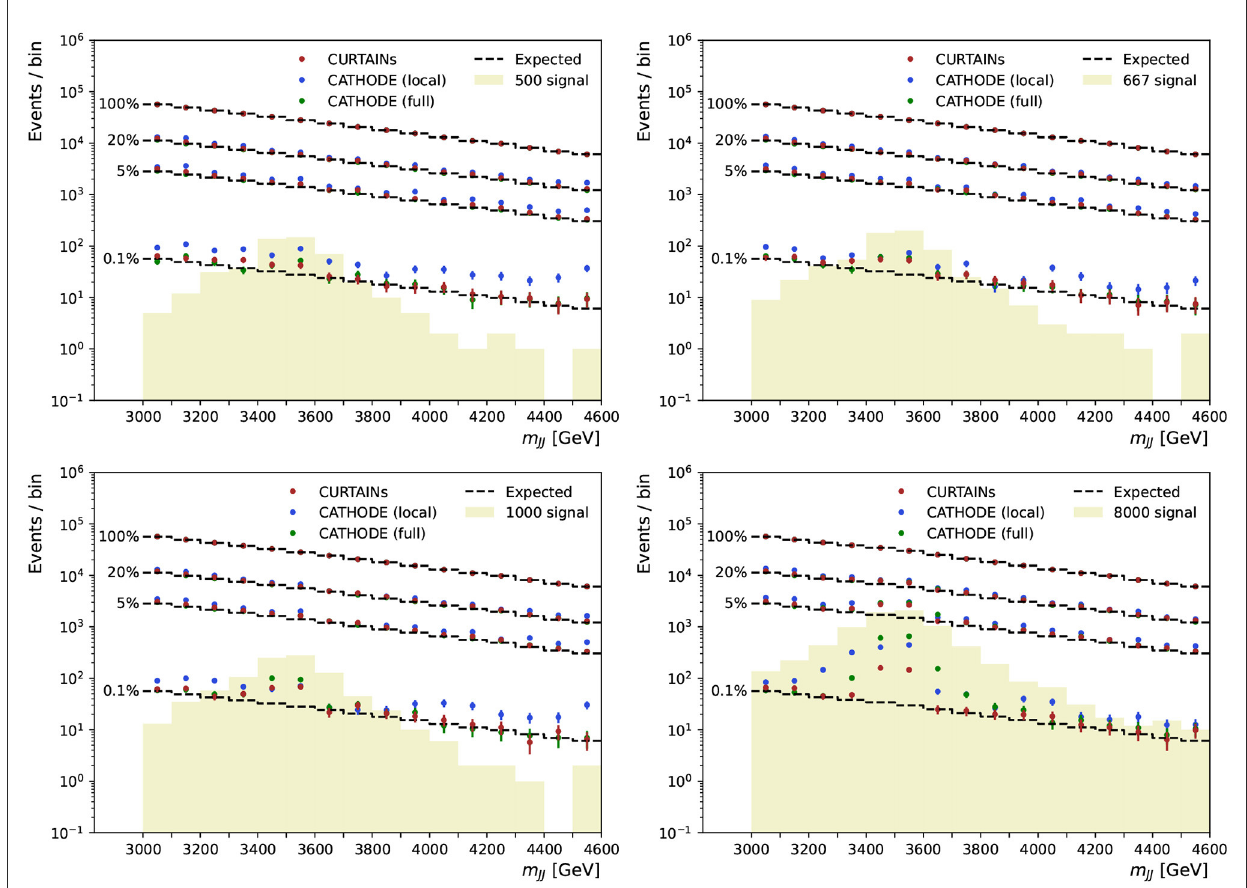
FIGURE10 The dijet invariant mass for the range of signal regions probed in the sliding window, from 3,300 to 4,600 GeV, for the case of samples doped with 500 (top left) , 667 (top right) , 1,000 (bottom left) , and 8,000 (bottom right) signal events. Each signal region is 200 GeV wide and split into two 100 GeV wide bins. The dashed line shows the expected background after applying a cut on classifier trained using the background predictions from the C URTAIN s (red), C ATHODE (local) (blue), and C ATHODE (full) (green) methods at specific background rejections. Three different cut levels are applied retaining 20, 5, and 0.1% of background events, respectively. The cut values are calculated per signal region using the background